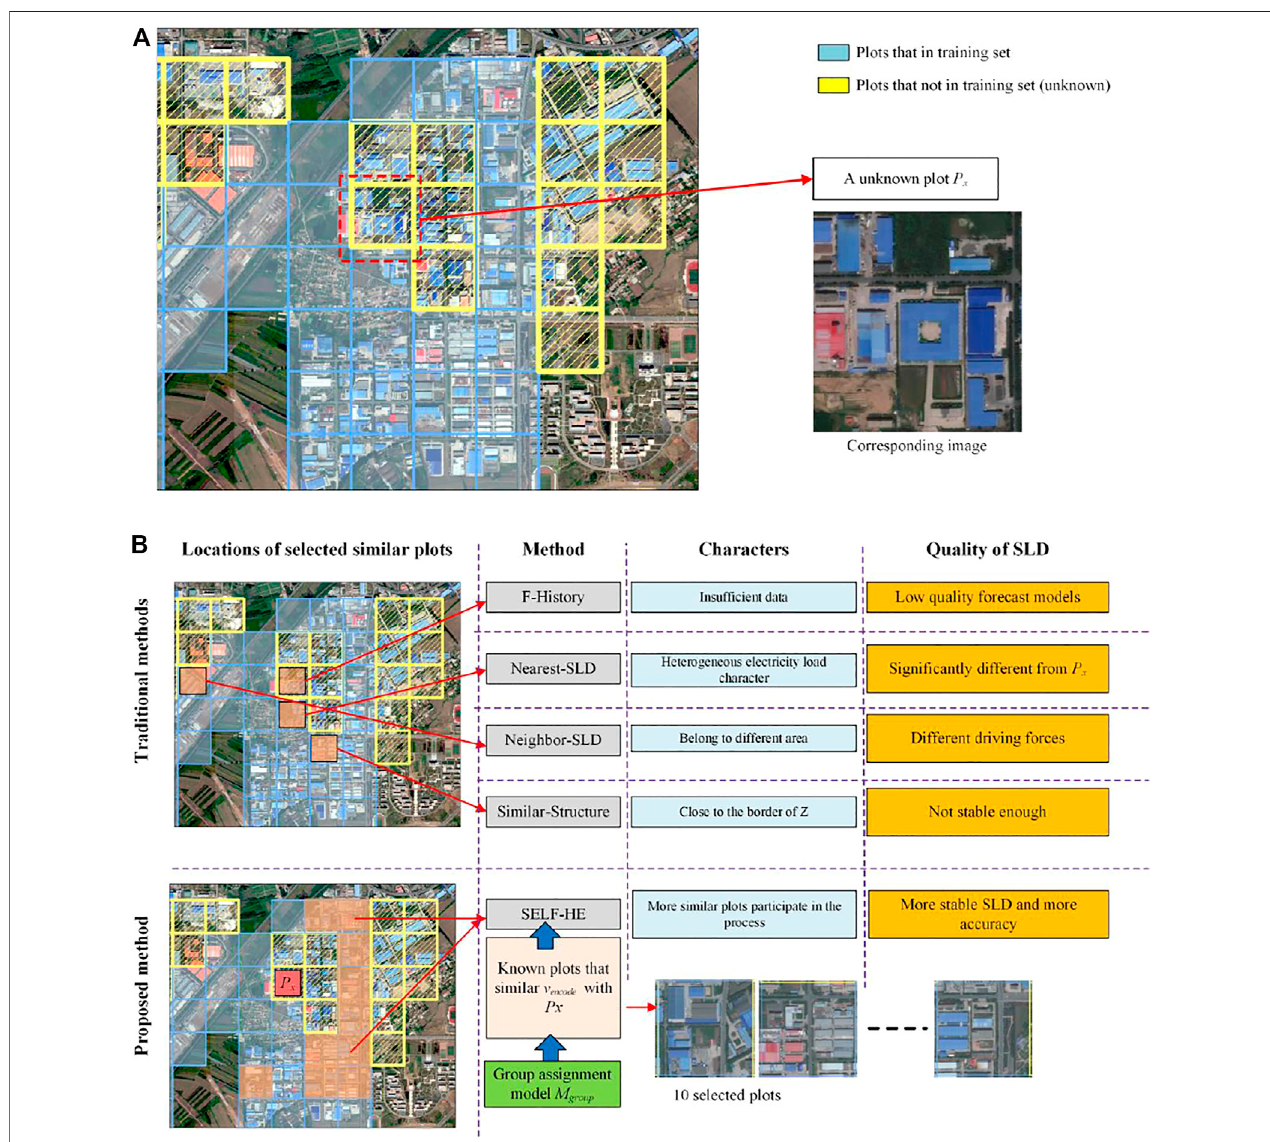
FIGURE 11 | Detailed process of each method: (A) unknown plot P x and (B) comparison of all the methods.